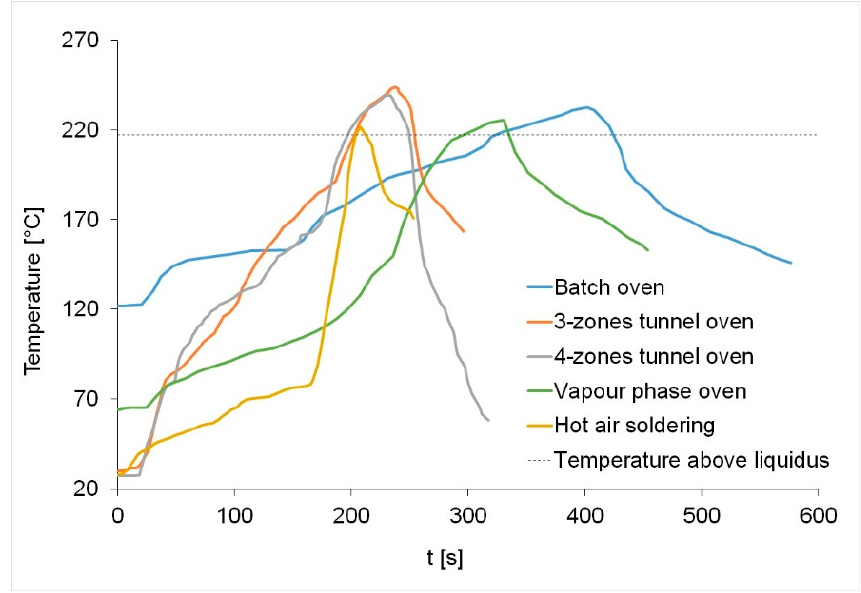
Figure 2. Test sample of NGB8207BN transistors soldered onto FR4 substrate.